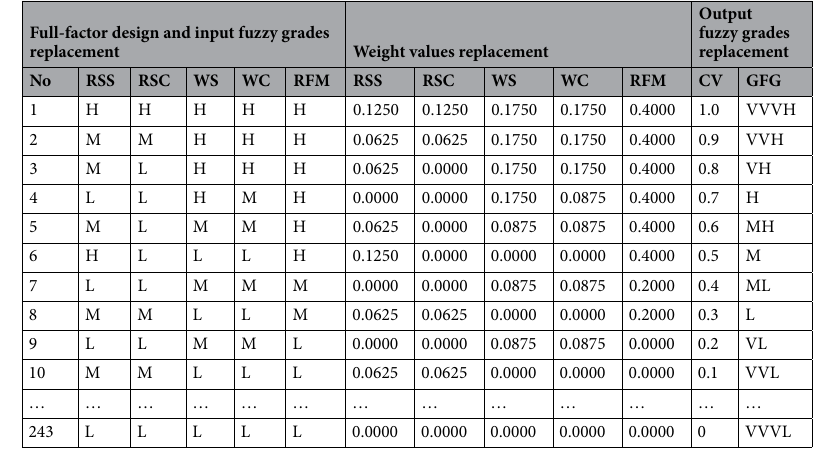
Table 15. The transformation of input fuzzy grade and output fuzzy